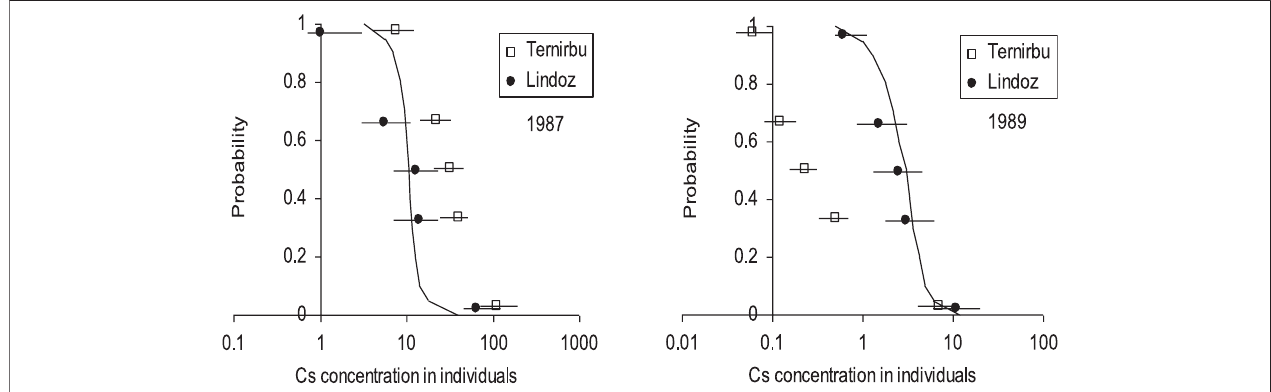
FIGURE 1 | The predictions by two of the thirteen research groups (Ternirbu and Lindoz) together with the actual outcomes for a site (continuous curve) in central Bohemiain1987and1989forCsconcentrationsresultingfromChernobylfallout.Thehorizontalbarsare95%con fi denceintervals.Thecurvesrepresenttheprobability (the proportion of individuals) in whom the concentration exceeded the concentration indicated on the x-axis (after [26], in